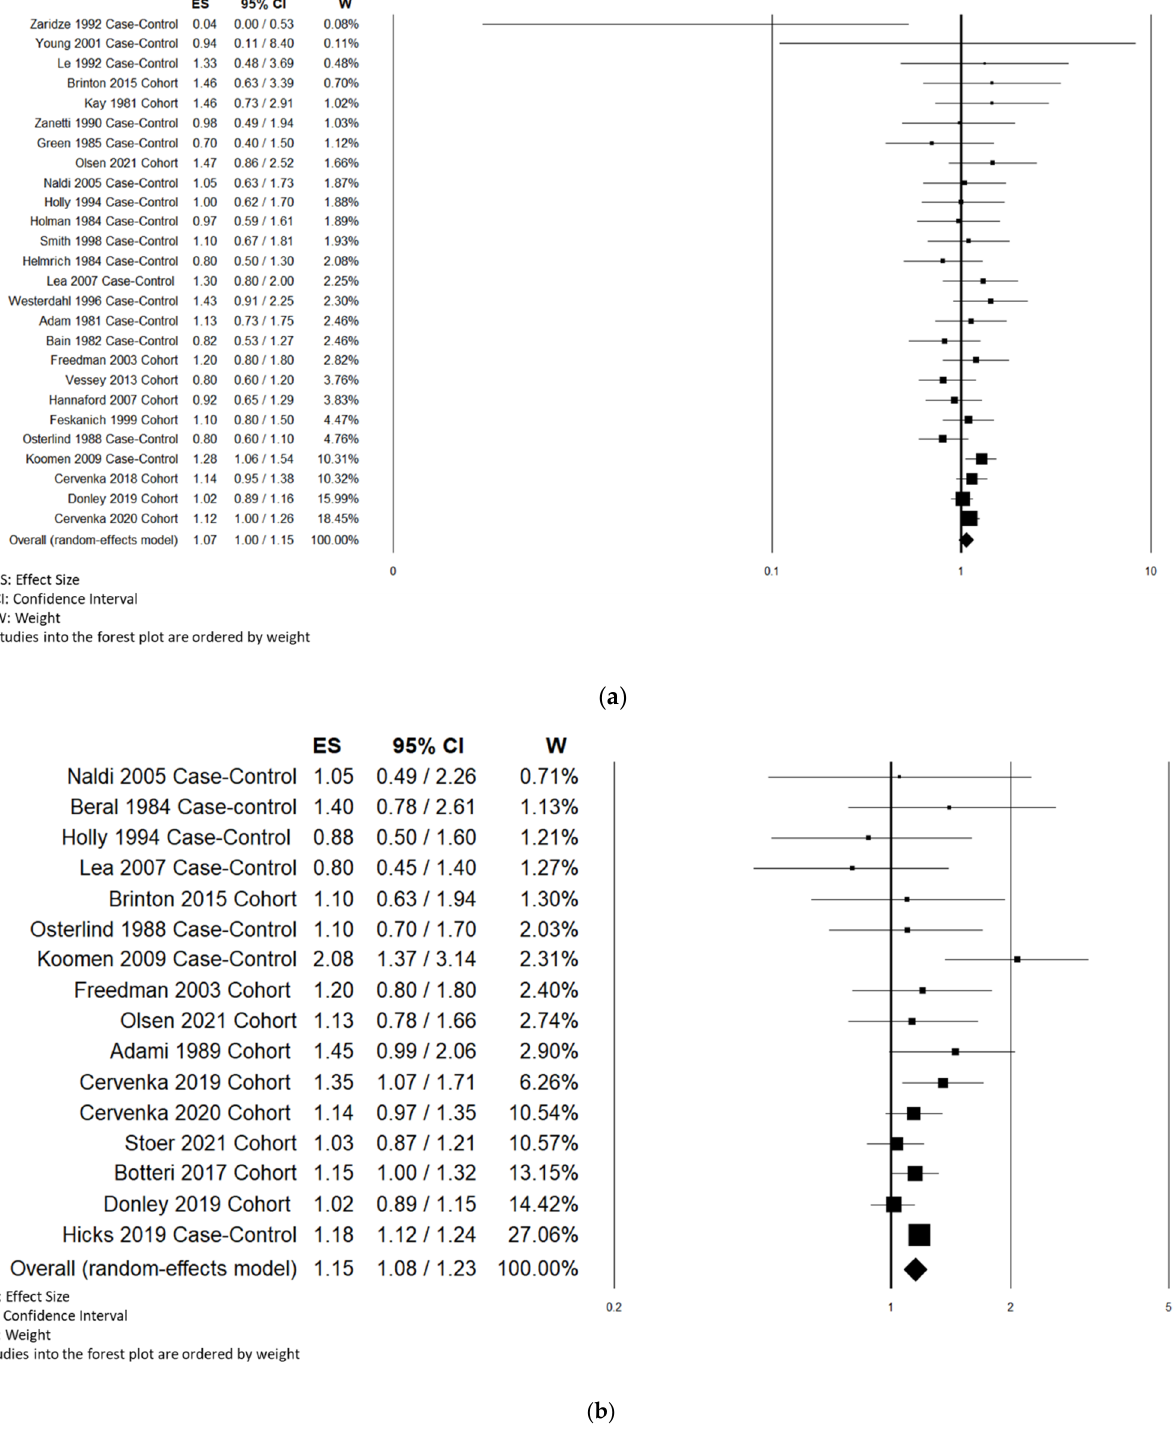
Figure 2. Forest plot of OC ( a ) and MHT ( b ) use and risk of CMM.